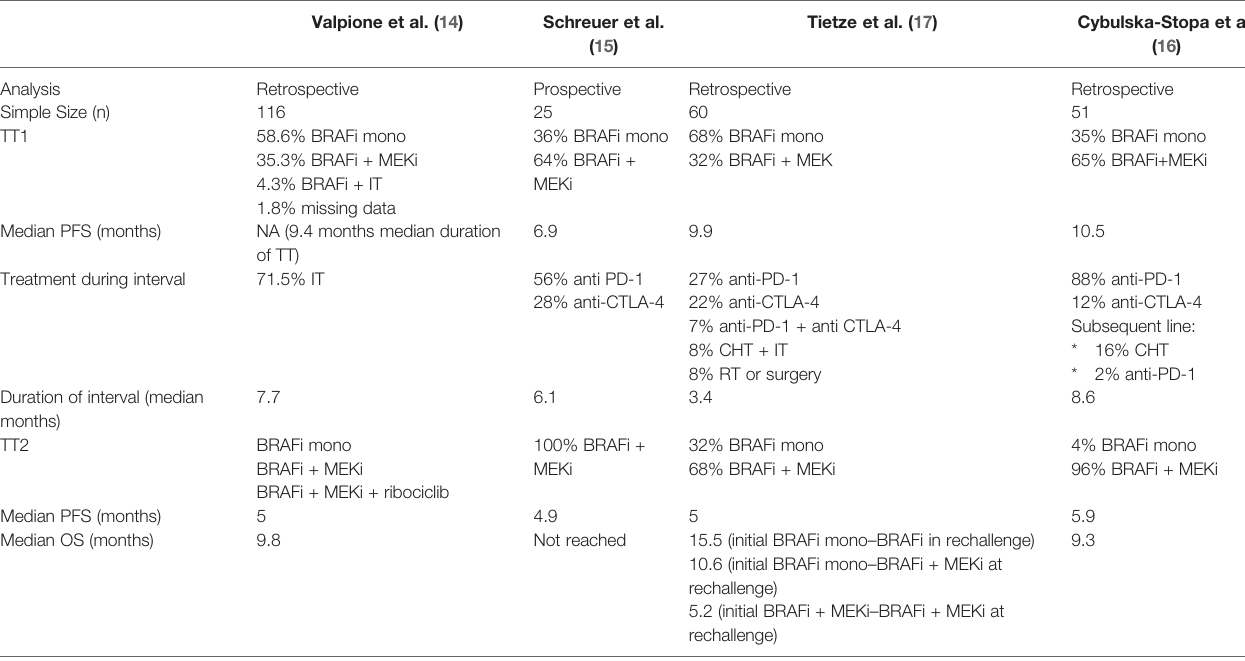
TABLE 1 | Summary of published data on the rechallenge of targeted therapy in